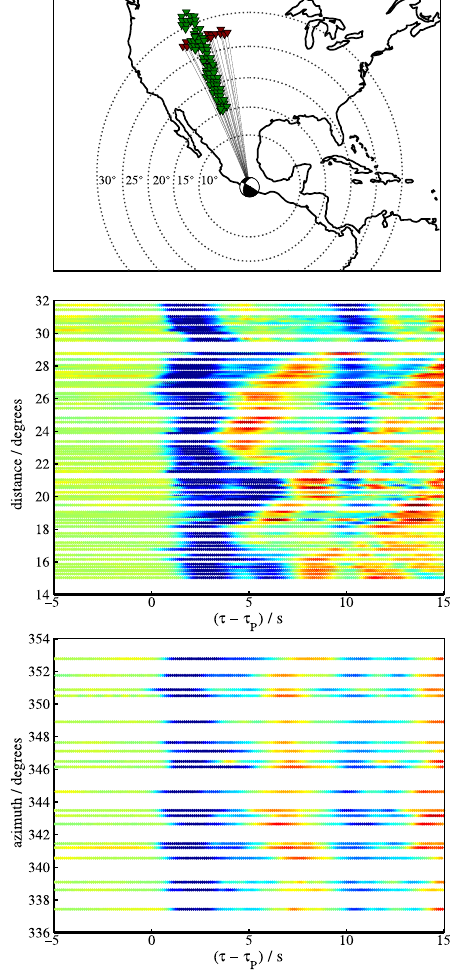
Fig. 10. Evidence of 3-D structural information contained in trip- licated P-waves. Top: we extract a quasi 1-D profile of 84 USAr- ray stations, recording an earthquake in Mexico (Event: 2009/04/27 16:46:28, Mag: 5.8, Lat: 17.03, Lon: –99.45, Depth: 35km). Mid- dle: Section of broadband seismograms at triplication distances (be- tween 22 and 35 ◦ , green in the map plot). Z-component, colour coded, green is zero displacement, blue negative, red positive. The traces are normalized separately, and aligned to the first arriving P- wave as predicted by IASP91 . See text for discussion. Bottom: Seis- mograms from the ensemble of stations at quasi-constant distance of 28 to 29 ◦ (red triangles in map plot). The second P-triplication is observed on some of the traces (at t = 4–5 s) but not on others, pointing to variations on the 660-km